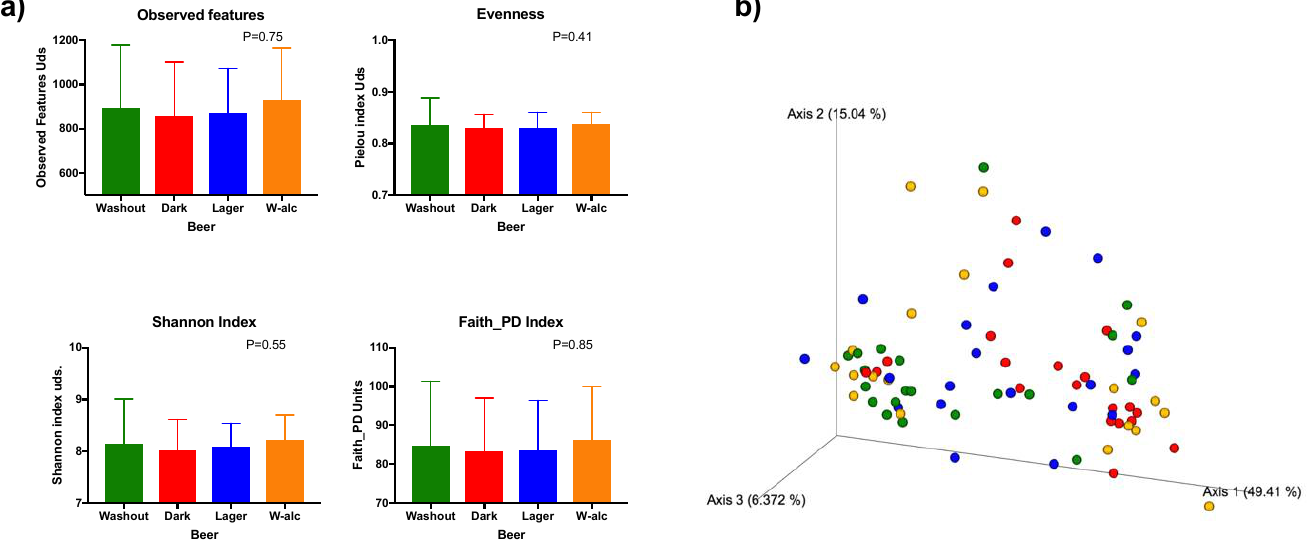
Figure 2. Gut microbiota diversities at the different beer periods. ( a ) Alpha diversity indexes: observed features, evenness, Shannon index and Faith_PD index; values are presented as mean ± SD (standard deviation). ( b ) Principal coordinates analysis plot of weighted Unifrac distance of fecal samples collected at the end of each beer period. Baseline (washout—green dots) and at the end of each intervention period (dark beer—red dots; lager beer—blue dots; alcohol-free beer—yellow dots).